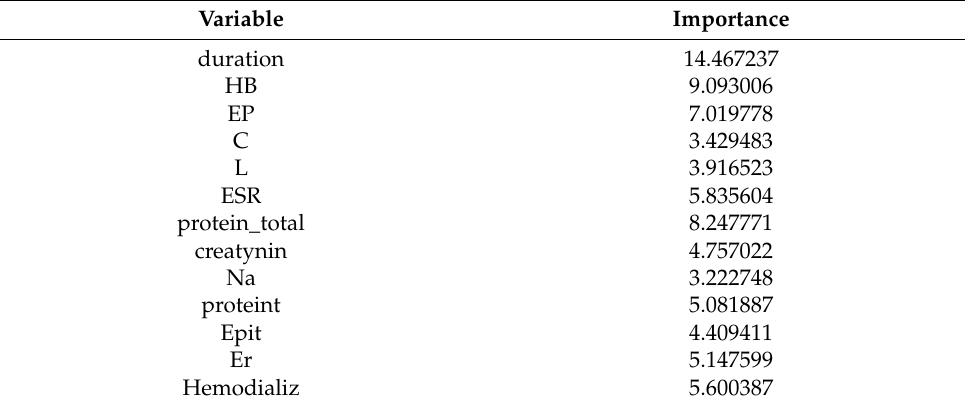
Table 1. The selected variables using Boruta algorithm.